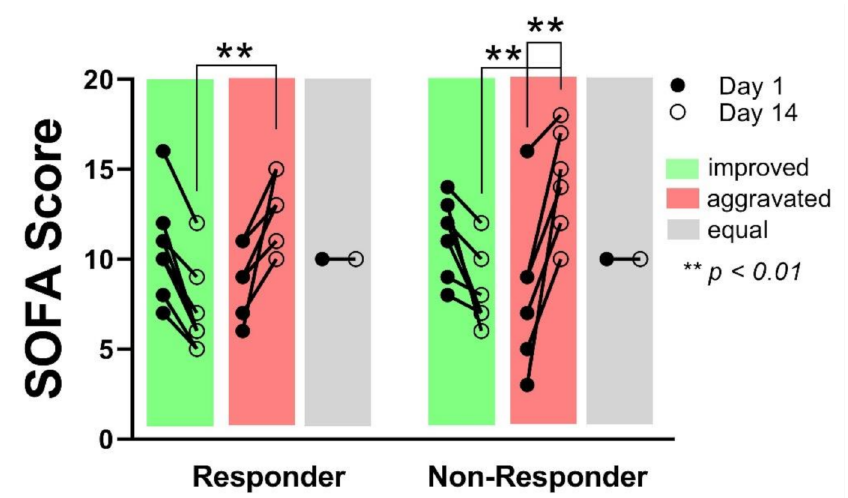
Figure 3. In both groups, an equal number of patients showed an improved sequential organ failure assessment sequential organ failure assessment (SOFA) score, respectively improved organ function after 14 days (green), as well as an aggravated (red), or unchanged (grey) organ function. SOFA score on day 14 was significantly different between improved- and aggravated organ function, independent from the groups (Responder vs. Non-Responder). Within the Non- Responder group, the SOFA score increase was significant from day 1 to day 14 for patients with aggravated organ